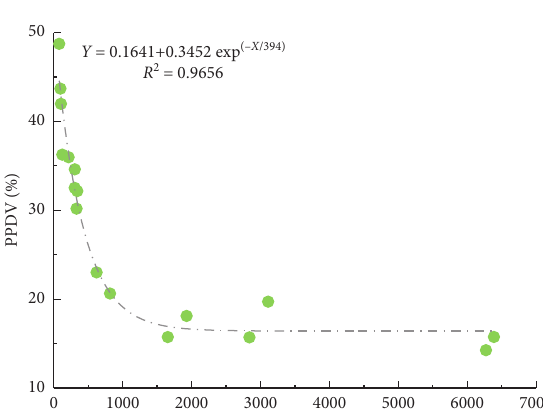
Figure 4: Overall change distribution of PPDV.